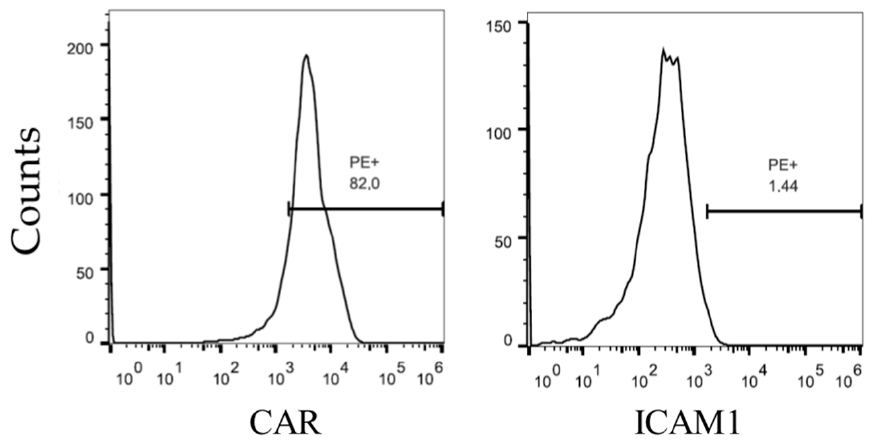
Figure 1. Basal surface expression of ICAM1, CD155 (the poliovirus receptor) and CAR on Vero cells as determined by staining with PE-labelled antibodies followed by flow cytometry. Vero cells express both CD155 and CAR on the surface but do not express ICAM1. This is indicated by the percentage of PE-positive cells in the right part of each graph.